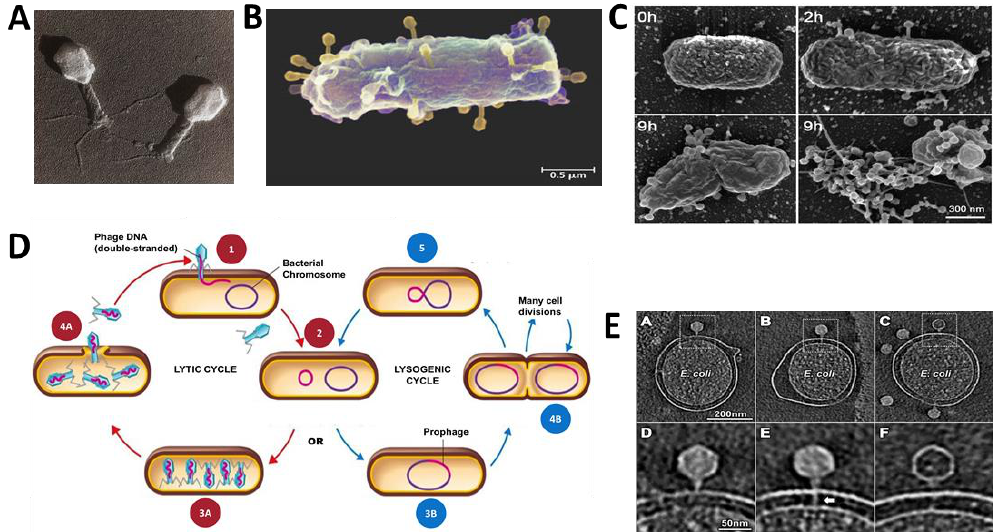
Figure 2. Introduction to lytic phage biology. ( A ) Shadowed Transition Electron Micrograph image of T4 phage (Mag 380,000 × ). This phage, a member in the Myoviridae family of the Caudovirales order, is one of the seven Escherichia coli phages (T1 – T7) in this family. This image shows the icosahedral capsid head containing the genetic material, the contractile tail, and the long tail fibers of the phage.